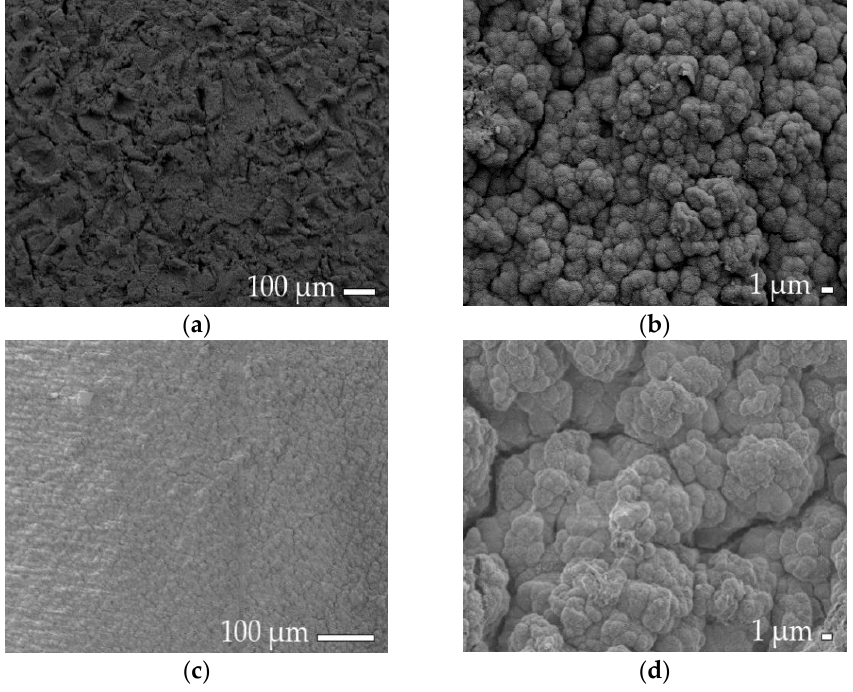
Figure 5. SEM images of the surface morphology of a textured AS sample at ( a ) magnification ×100 and ( b ) ×4000 after electrodeposition at 30 V for 10 min, and a textured Al-Mg sample at ( c ) magnification ×180 and ( d ) ×3000 after electrodeposition at 40 V for 30 min.